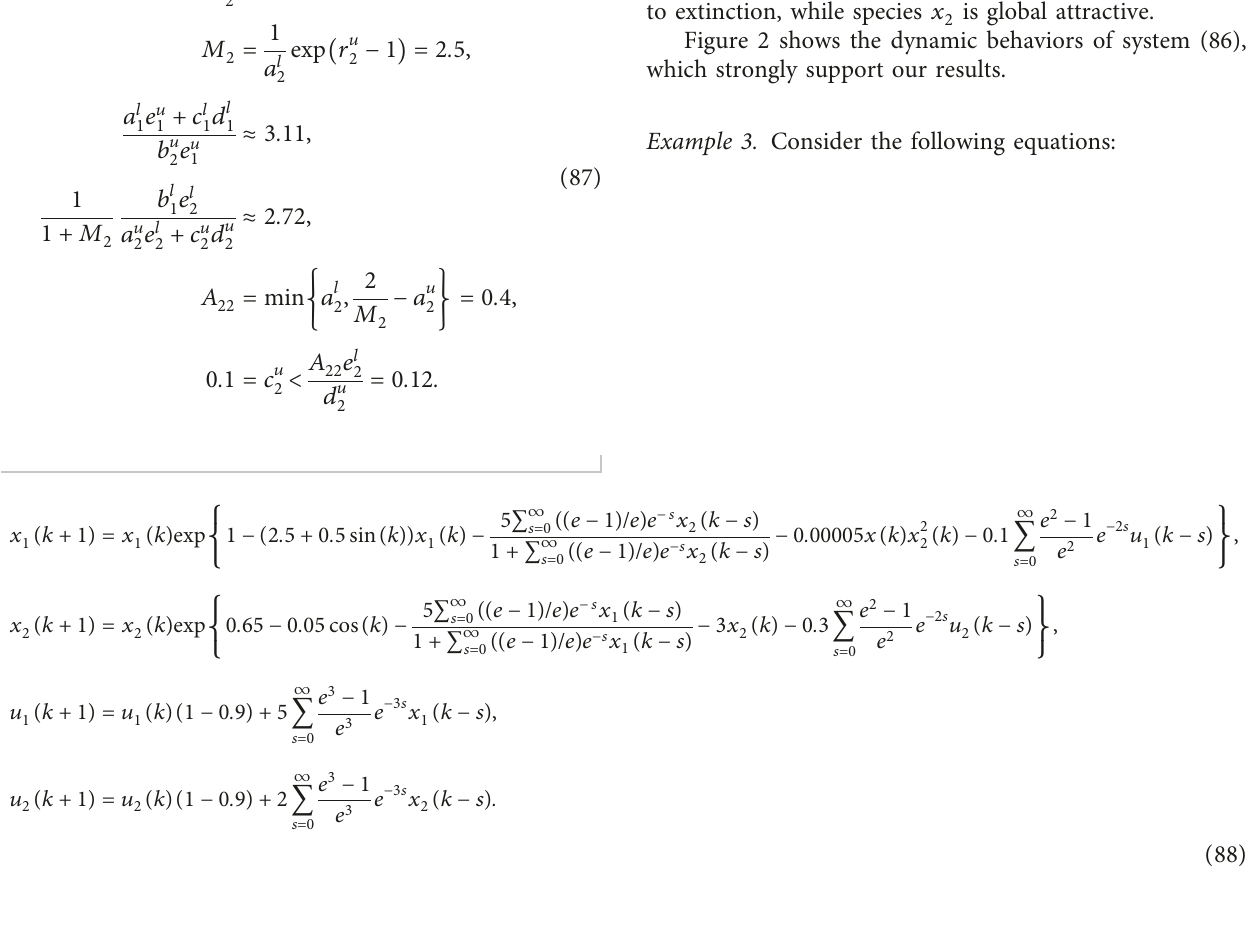
, 0 . 32 , 0 . 4 , 0 . 43 , 0 . 7 ) (